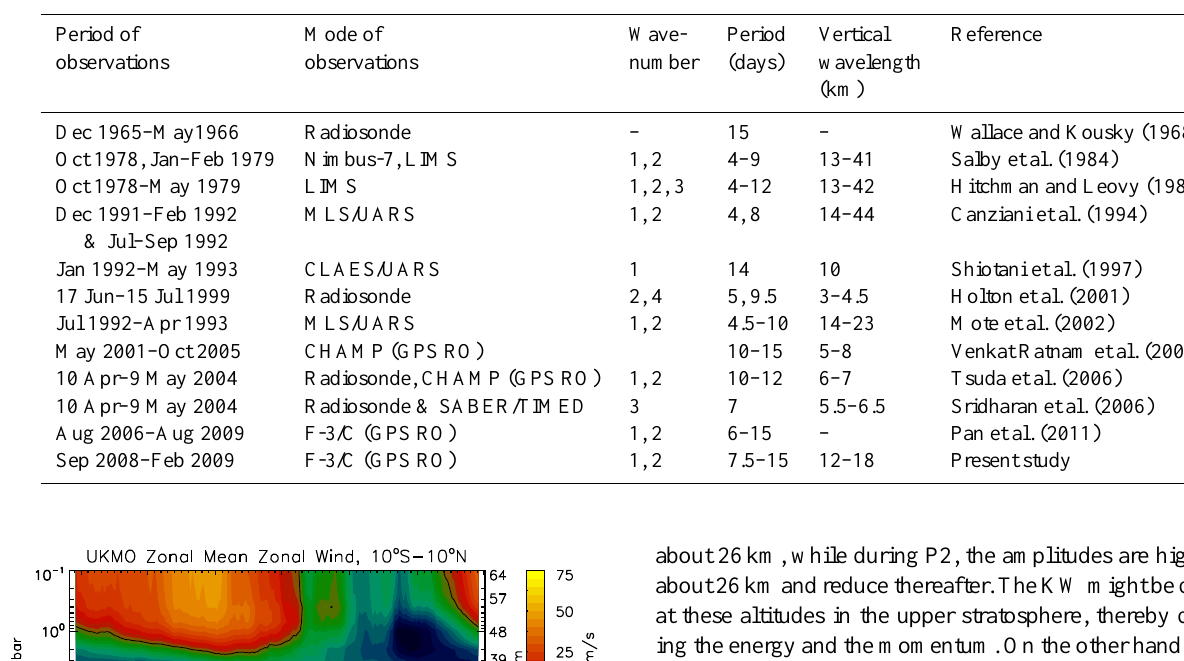
Table 1. KW properties in the middle atmosphere from literature.